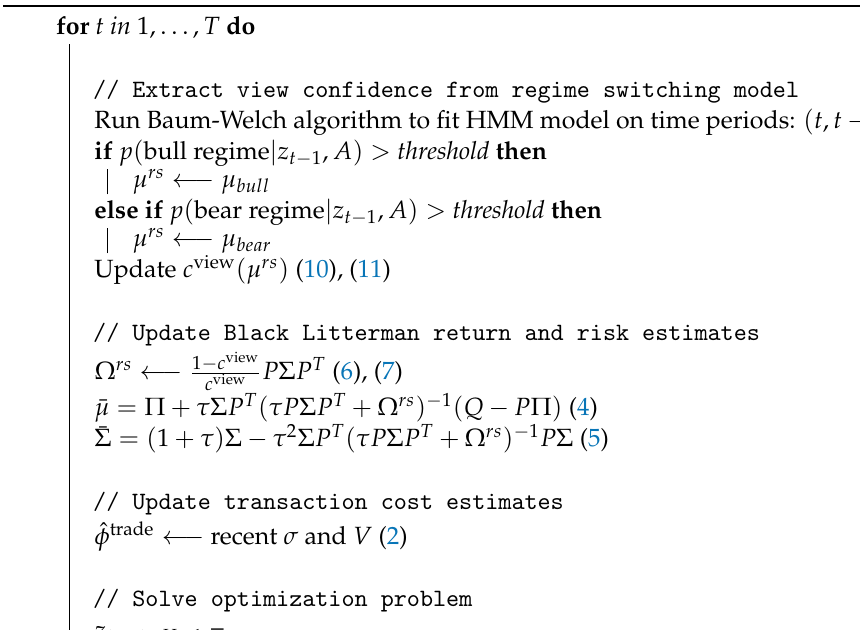
Algorithm 1: Multi-Period Portfolio Optimization Simulation Pseudo-Code. for t in 1, . . . , T do // Extract view confidence from regime switching